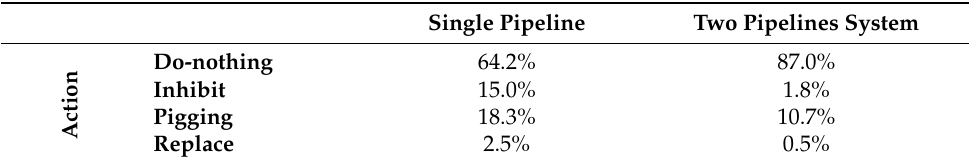
Table 8. Recommended action percentage for single and two-pipeline